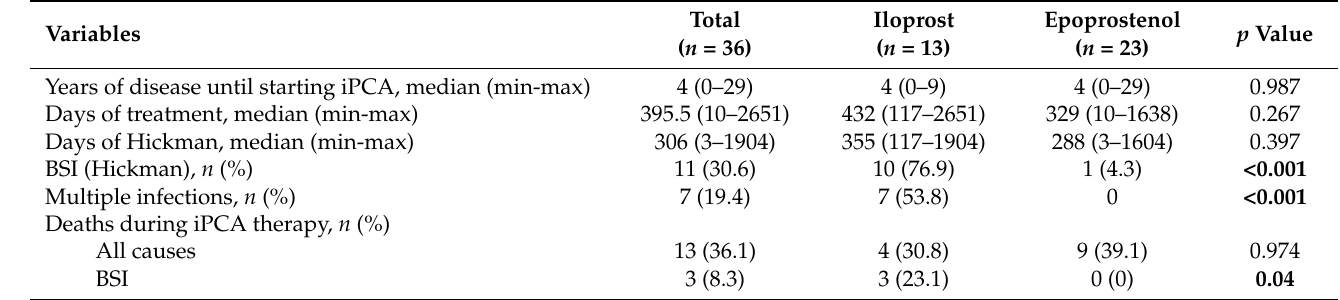
Table 3. Characterization of treatment periods and the occurrence of BSI.